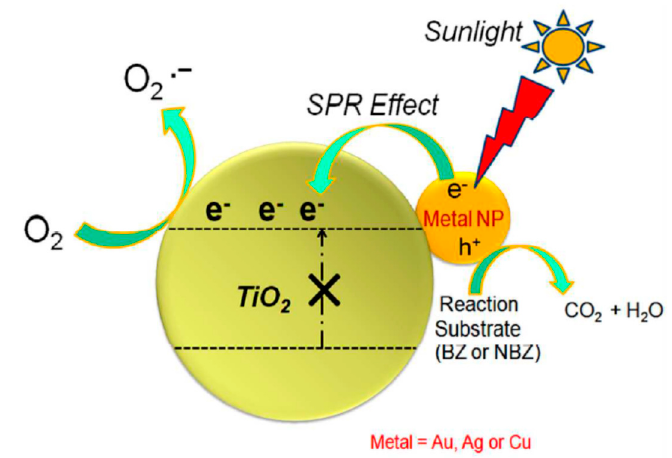
Figure 1. Surface plasmon resonance (SPR) effect of metal nanoparticles for TiO 2 photocatalysis under sunlight irradiation. Reprinted with permission from [52]. Copyright Royal Society of Chemistry, 2015.